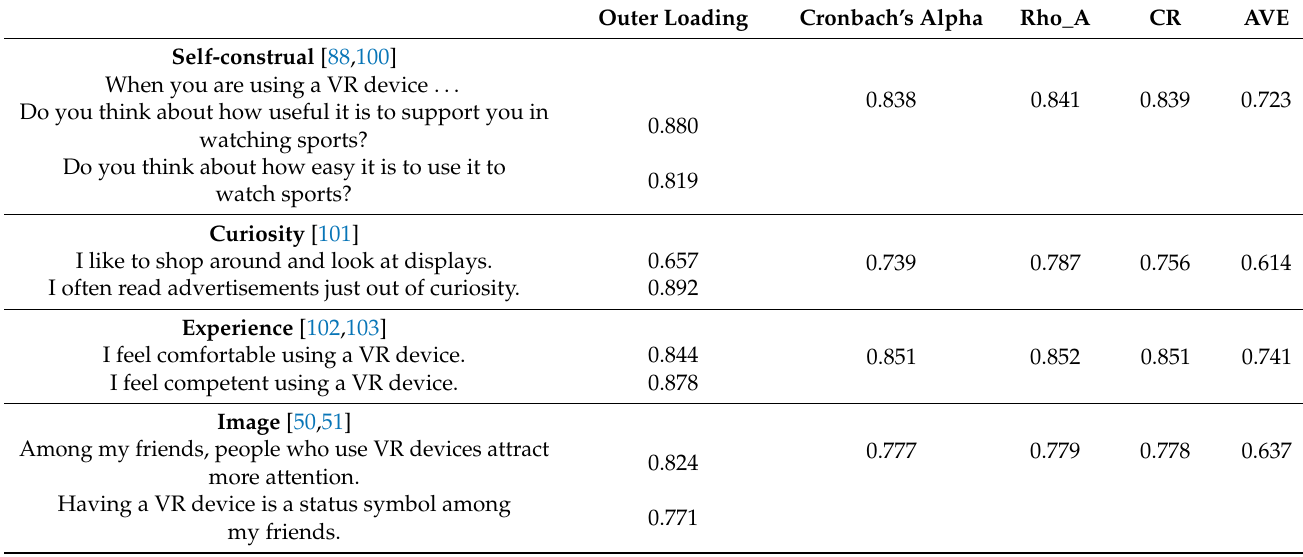
Table 2. Measurement model